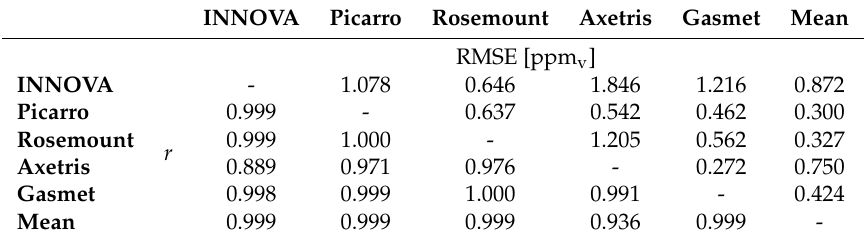
Table 2. Pair-wise correlation coefficients ( r , low-left diagonal) and root-mean-square errors (RMSE, upper-right diagonal) among five tested gas analysers and the mean on measuring ammonia (NH 3 ) (ranged between 0.98 and 19.1 ppm v ) in the field over 30 trials. The mean represents the unweighted average of available analyser measurements per